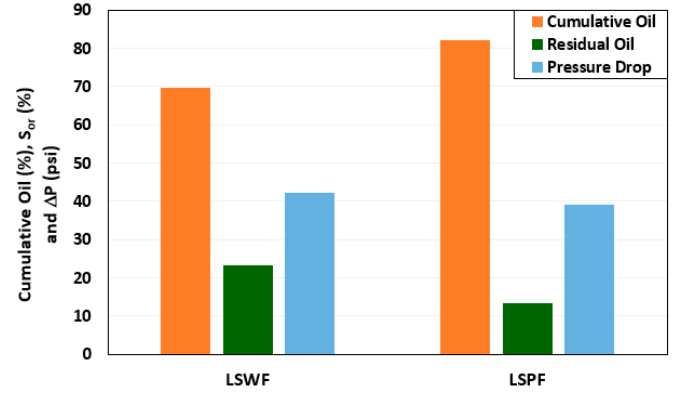
Figure 17. Oil recovery as a function of the zeta potential, showing higher recovery using the hybrid method compared to standalone processes. Coreflood-1 shows a comparison between PF and LSPF, while coreflood-2 displays a comparison between LSW and LSPF [139].